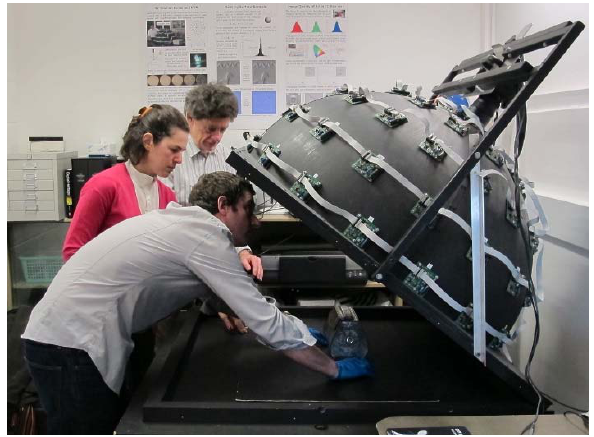
Figure 6. Placing the handbag on the baseplate of the UCL dome. For photography the hinged upper part was lowered onto the frame, so that the object was completely enclosed. Photograph by Jananne Al-Ani.